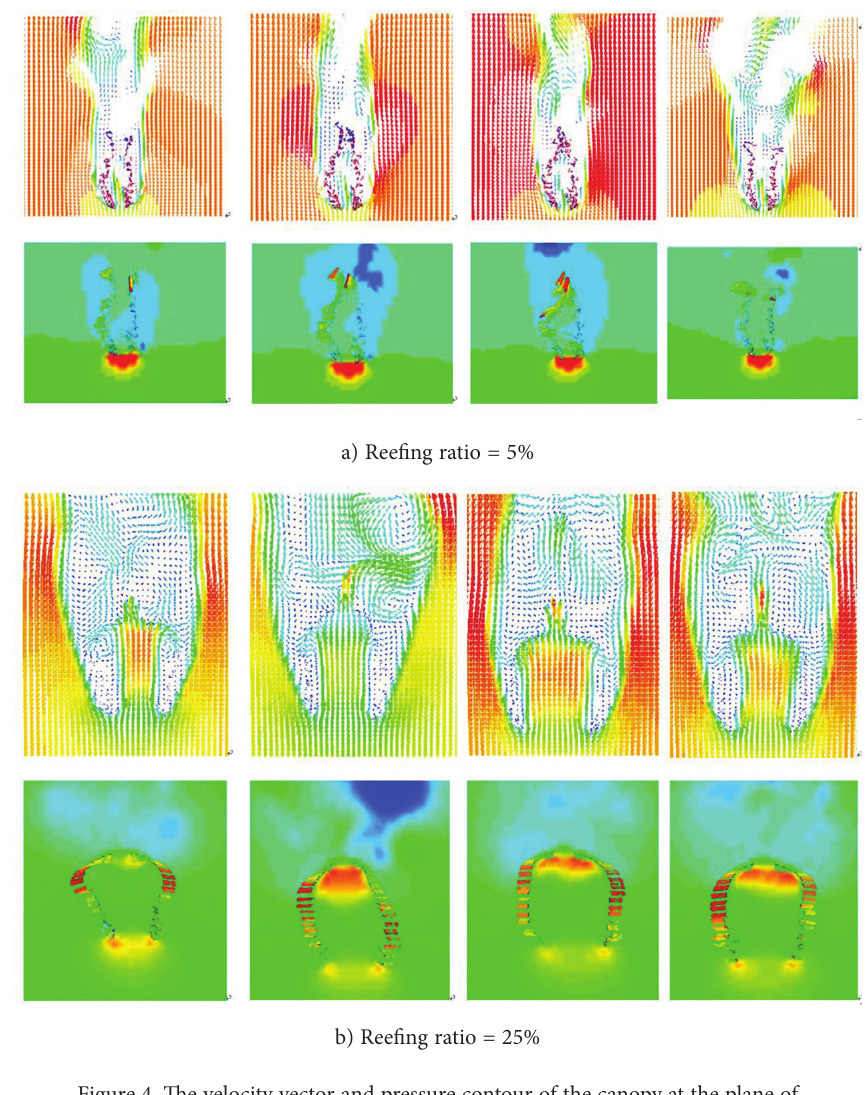
Figure 4. The velocity vector and pressure contour of the canopy at the plane of symmetry (t = 0.45, 0.55, 0.65, 0.8